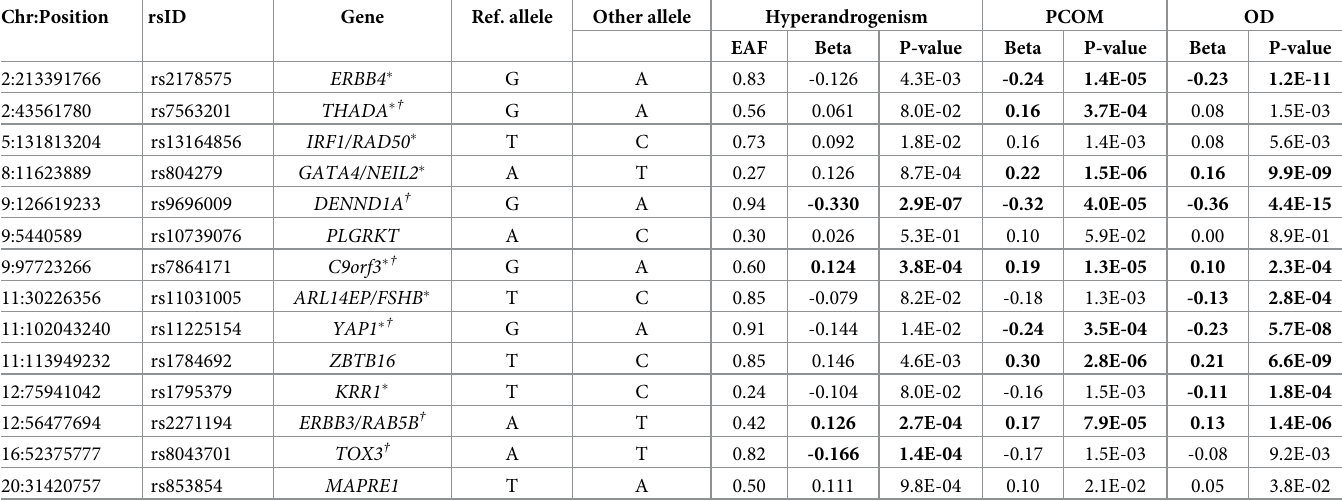
Table 3. Association of PCOS GWAS meta-analysis susceptibility variants and PCOS related traits.